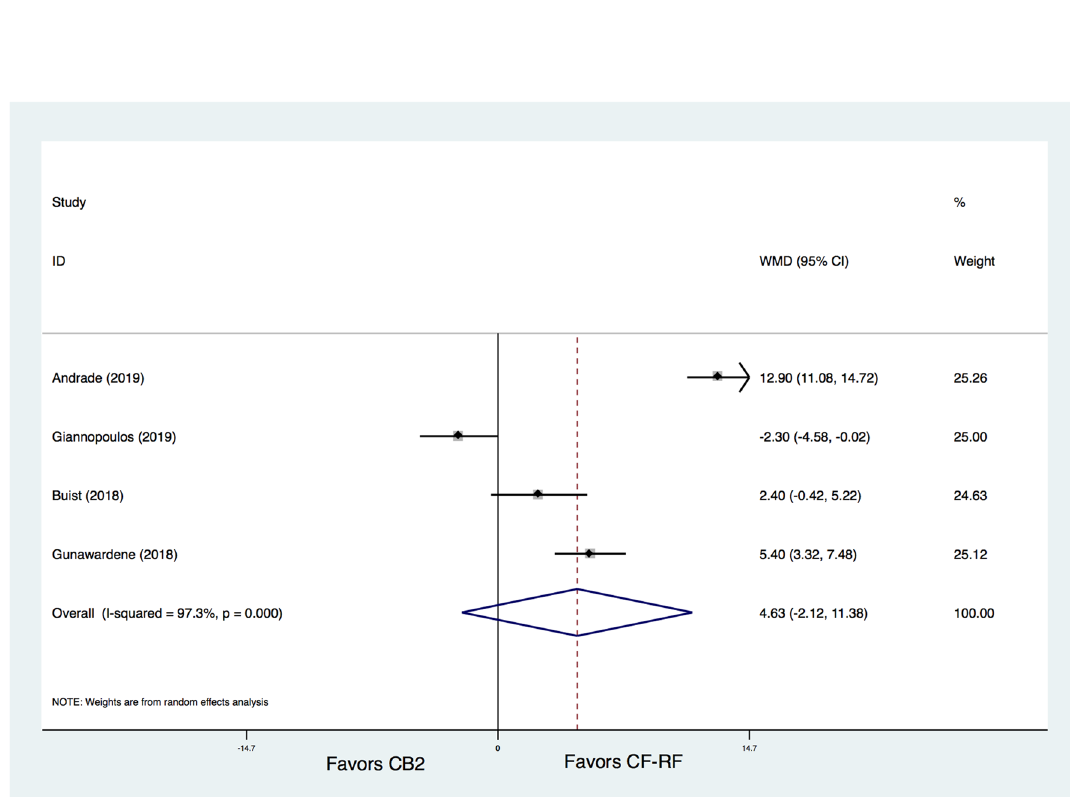
Figure 7. Meta-analysis for the outcome of fluoroscopy time. CF-RF = contact force radiofrequency ablation; CB2 = cryoballoon ablation (CBA) with a second-generation cryoballoon; WMD = weighted mean